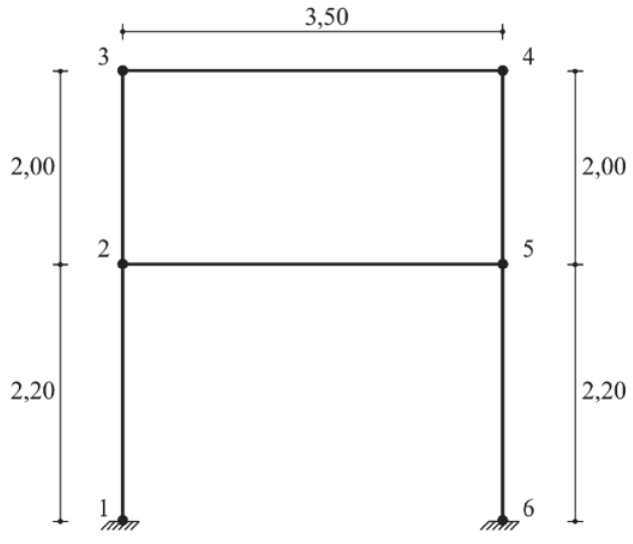
Finite element mesh 2D RC frame. Dimensions in